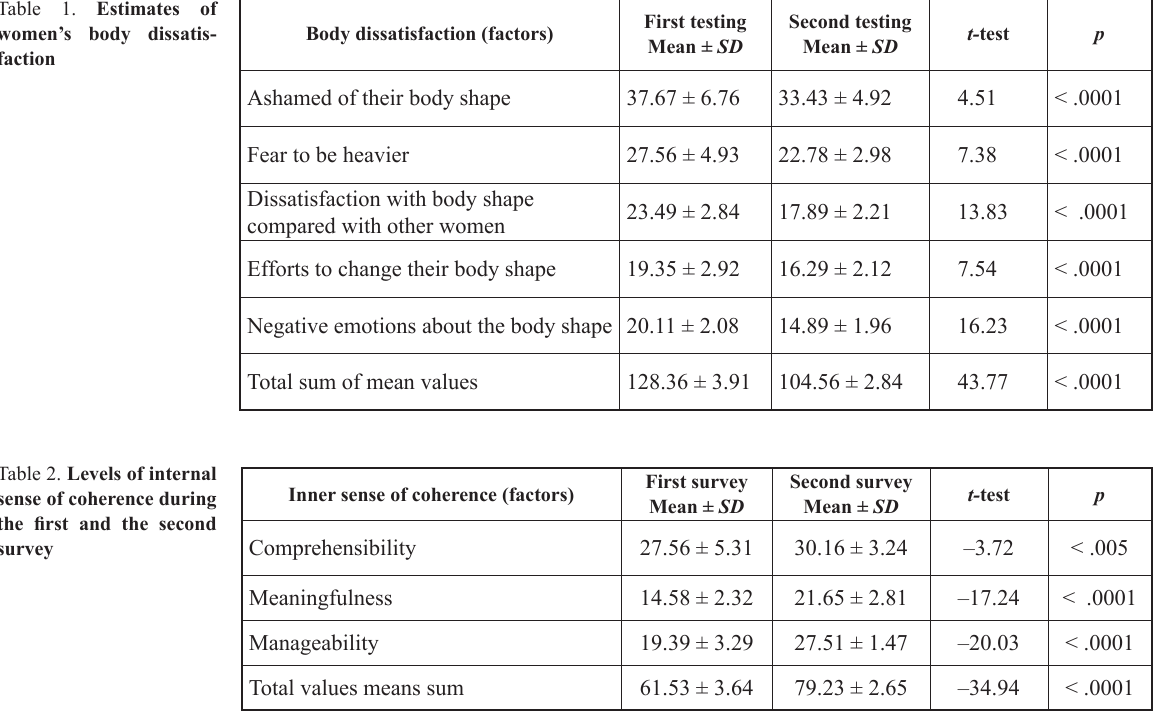
Table 1. Estimates of women’s body dissatis - faction